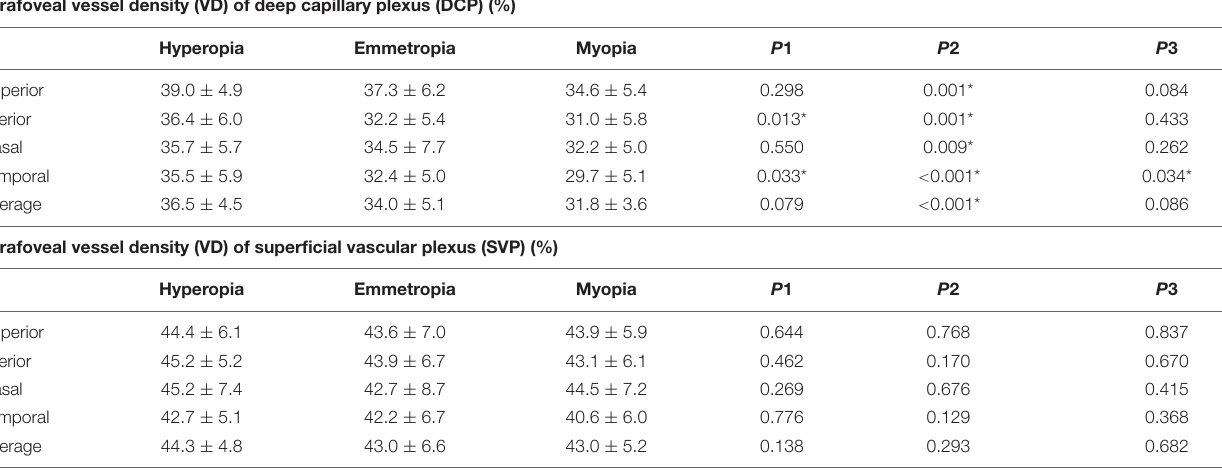
P1: Comparison between hyperopia and emmetropia; P2: Comparison between hyperopia and myopia; P3: Comparison between emmetropia and myopia. ∗ Significance of difference. GEEs for the intergroup comparisons. Age and sex have been adjusted. ∗ Significance of difference.